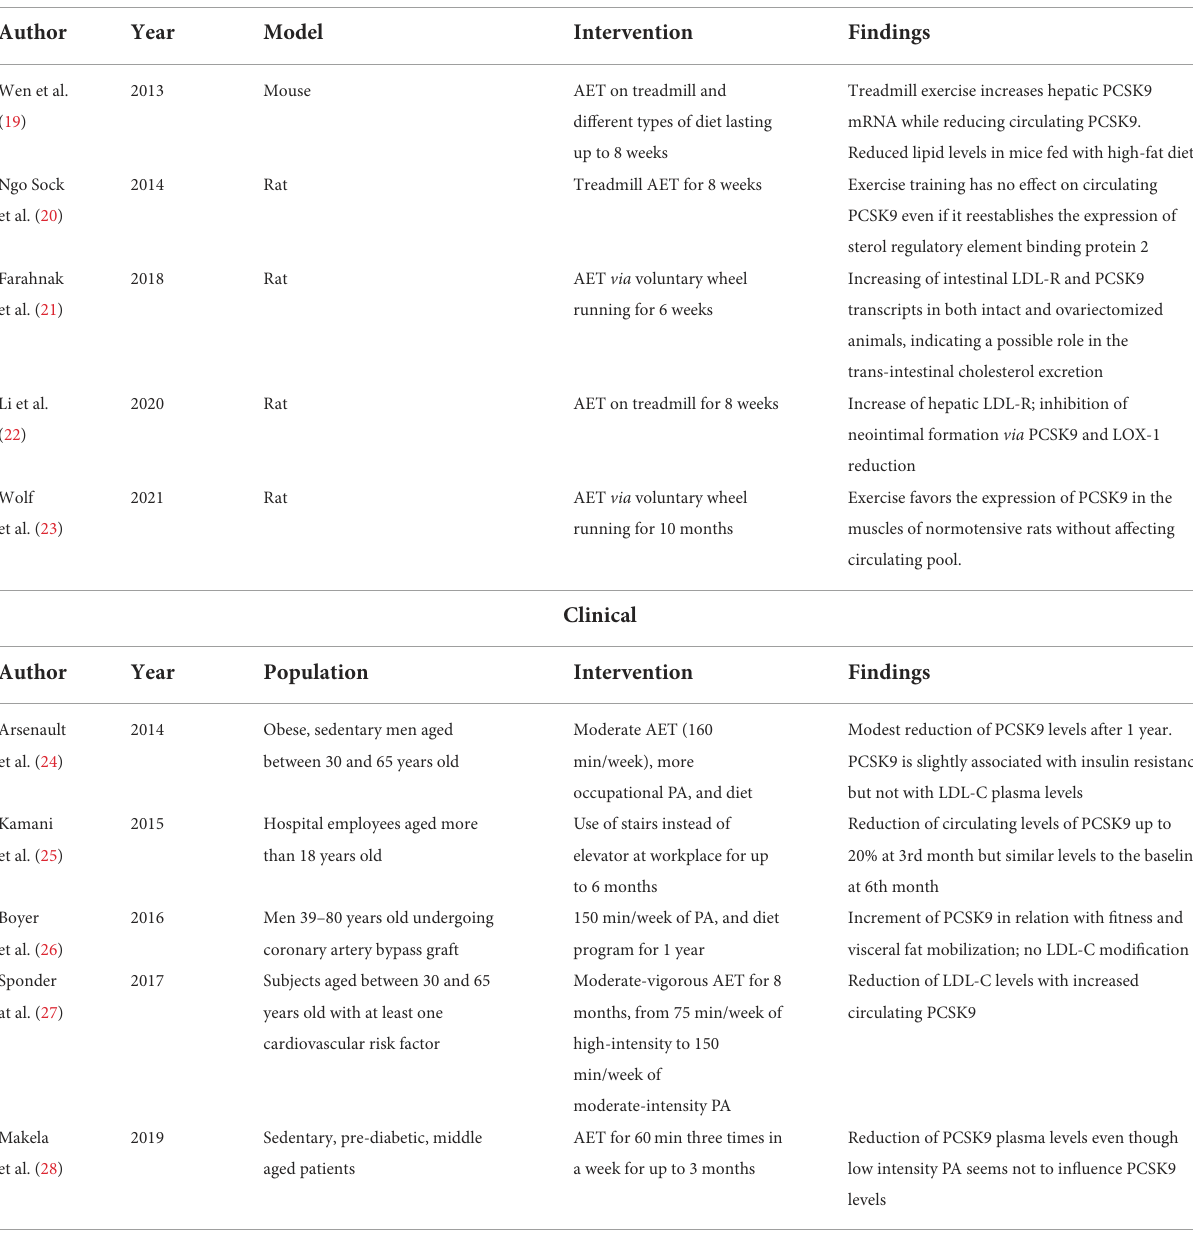
TABLE 1 Summary of recent pre-clinical and clinical studies evaluating the effect of exercise training on